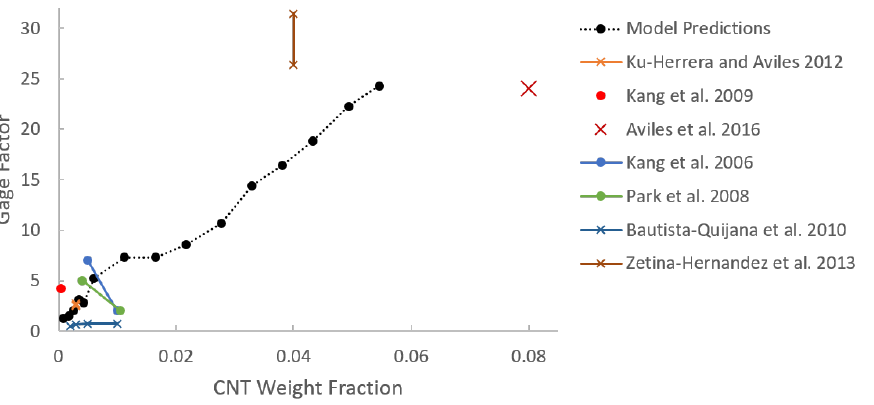
Figure 26. Comparing gage factors for randomly oriented straight CNTs from modeling predictions with characterization efforts in the literature